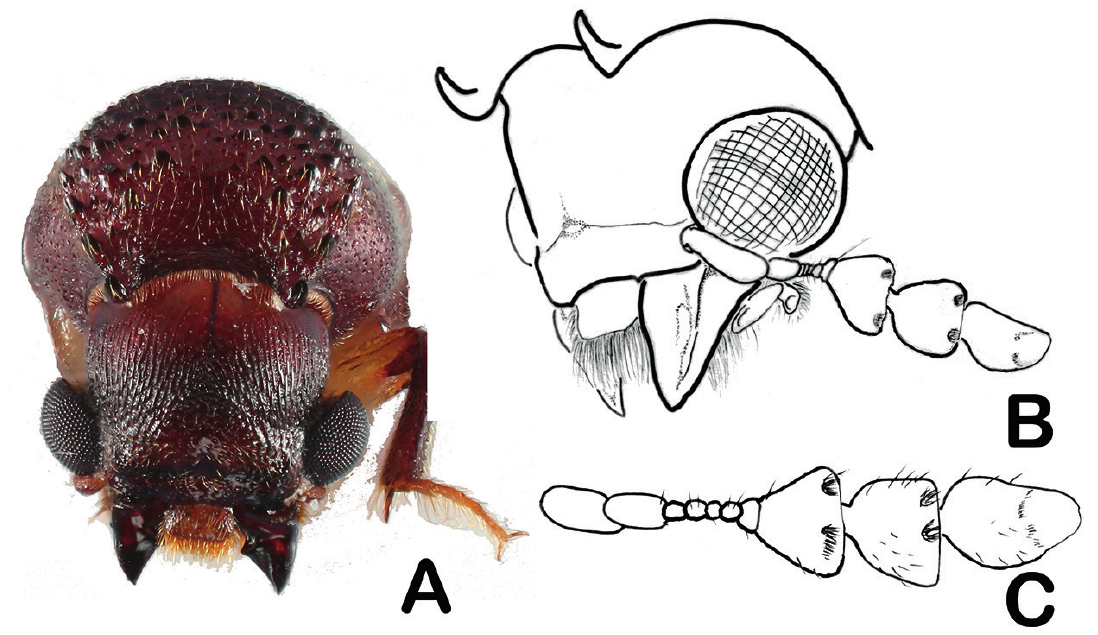
Fig. 1. Head of Infrantenna fissilis gen. et sp. nov., ♂ , holotype (NHMUK014433955). A . Frontal view. B . Fronto-lateral view. C . Antennae. Not to